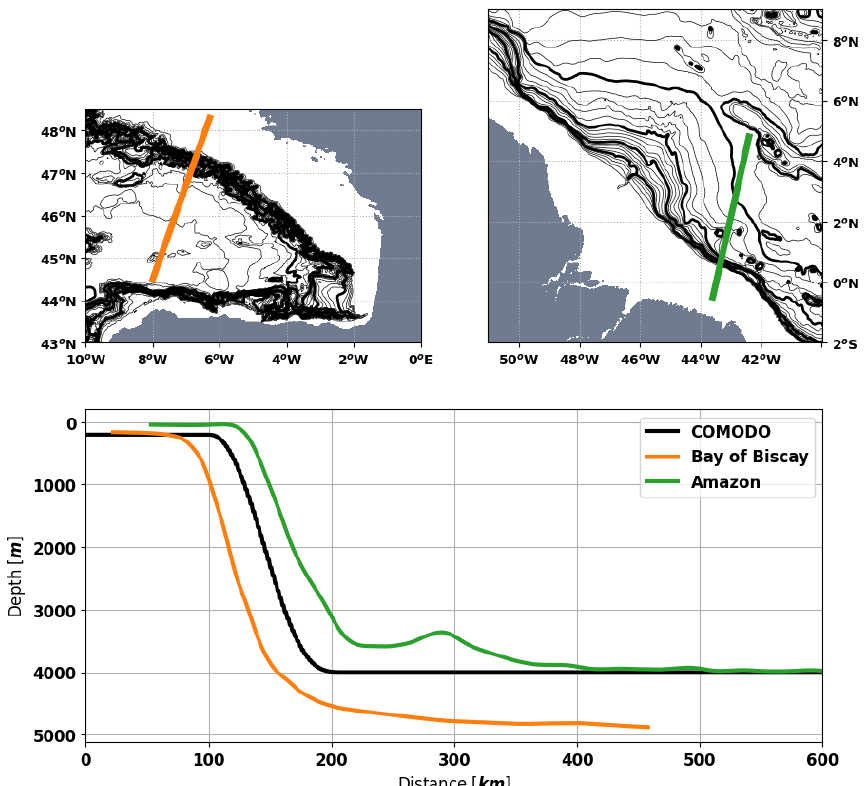
Figure B1. Realistic continental slope bathymetry over the two studied areas compared with the COMODO one. The bold contours show the isobaths spaced every 1000m and the plain ones every